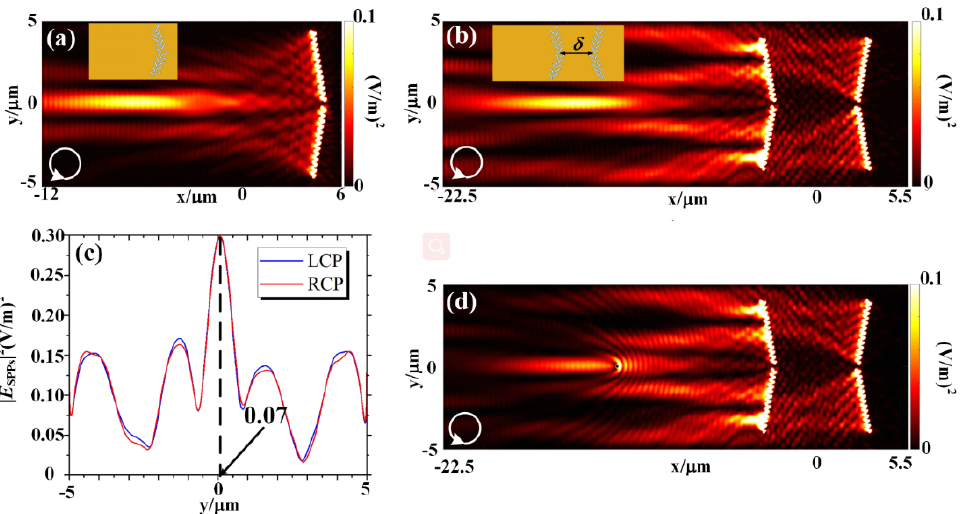
Figure 2. ( a , b ) The nondiffracting SPP-beam intensity distribution of a single-aperture array and two-aperture array when the incident light is LCP. ( c ) The transversal electric field intensity distributions at x = ± 13 µ m for the incident polarization are LCP and RCP. ( d ) The intensity distribution of the nondiffracting SPP beam in the case that there exists a cylinder obstacle.